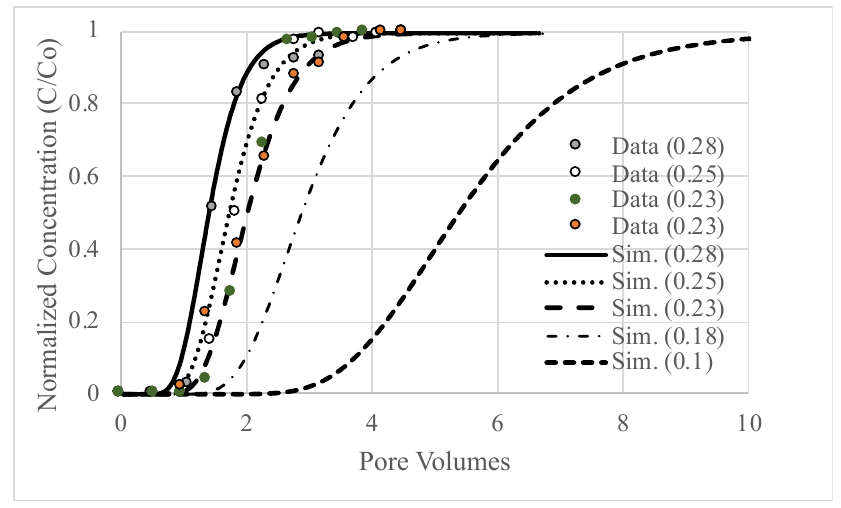
Figure 2. Experimental and simulated PFOA breakthrough profiles. Experimental data from [23]. Numbers in parentheses are the Θ (cid:3050) values.